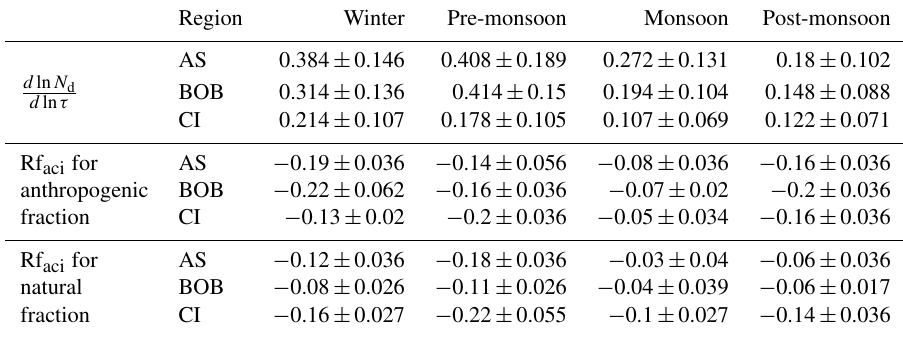
Table 2. Seasonal and regional sensitivities d ln N d /d ln τ a of cloud droplet number concentration N d to the changes in aerosol optical depth used in this study. The given standard deviation is derived from minimum and maximum values for a particular season. The associated range in RF aci is also estimated where the standard deviation of RF aci shows the variation due to change in d ln N d /d ln τ a . Variation due to change in d ln N d /d ln τ a .